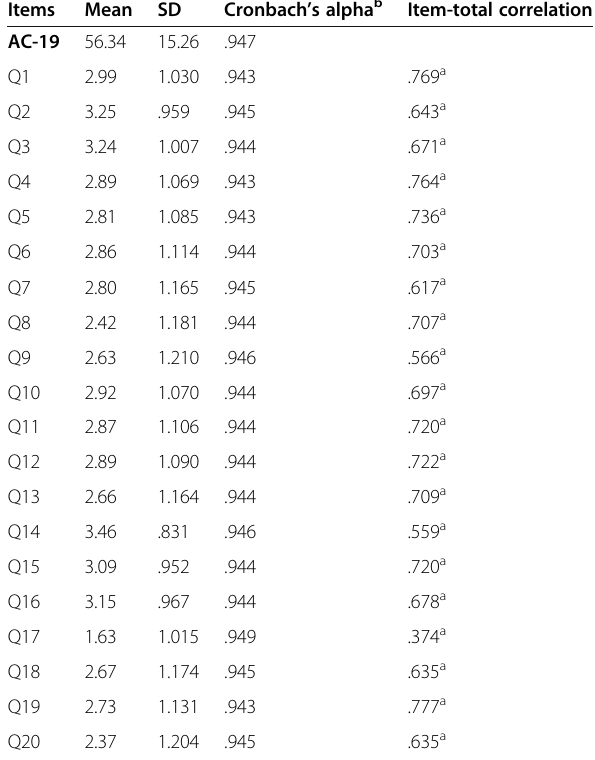
Table 6 Mean, standard deviation (SD), Cronbach ’ s alpha, and item-total correlation of each item in C-19LAI